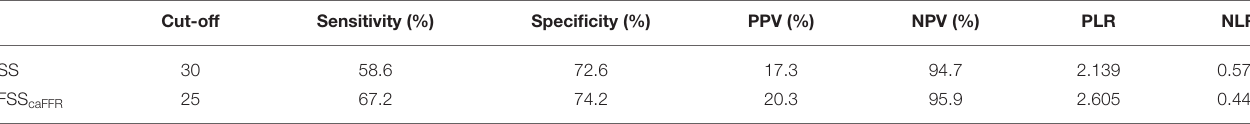
TABLE 4 | The best cut-off value, sensitivity, specificity, positive predict value, negative predict value, positive likelihood ratio, negative likelihood ratio of SS and FSS caFFR . Cut-off Sensitivity (%) Specificity (%) PPV (%) NPV (%) PLR NLR SS 30 58.6 72.6 94.7 0.570 FSS caFFR 25 67.2 74.2